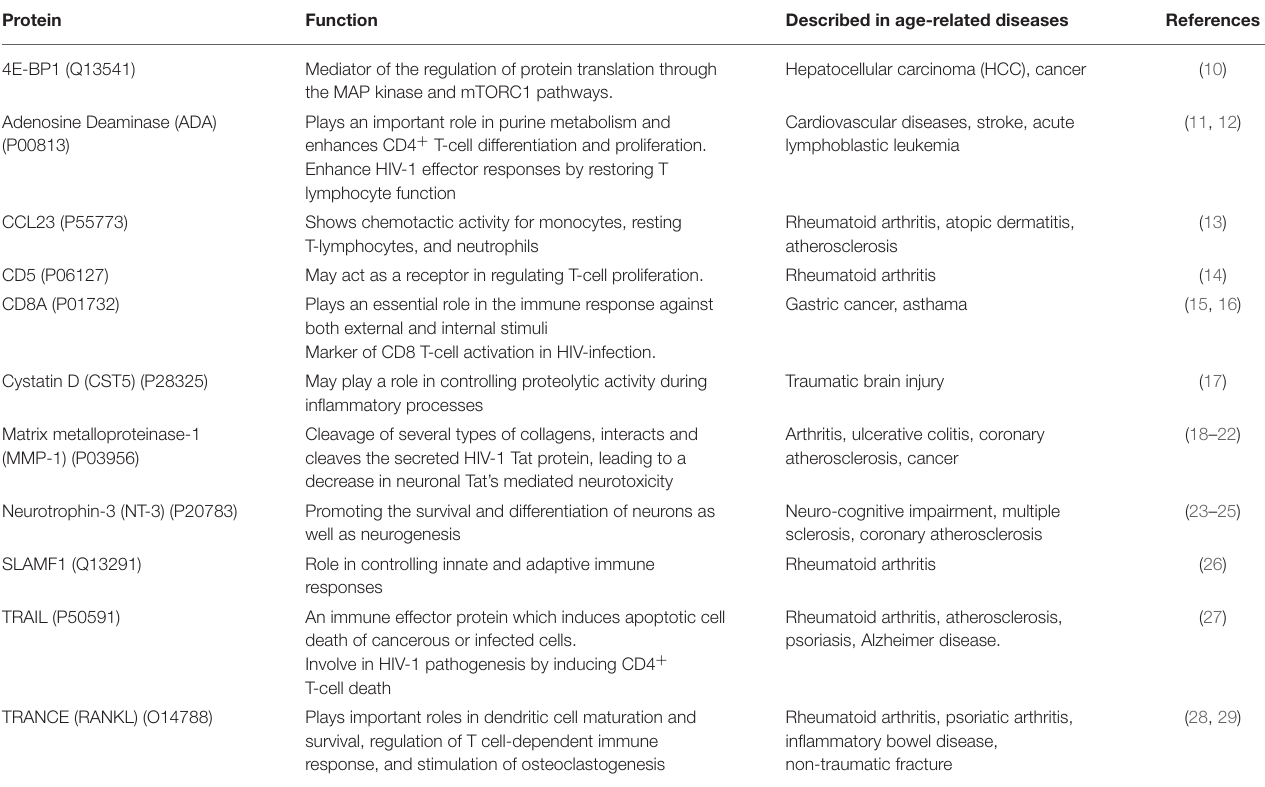
TABLE 2 | Summary of statistically different proteins between ART and HIVNC and their role in disease pathogenesis and biomarkers of age-associated diseases. Protein